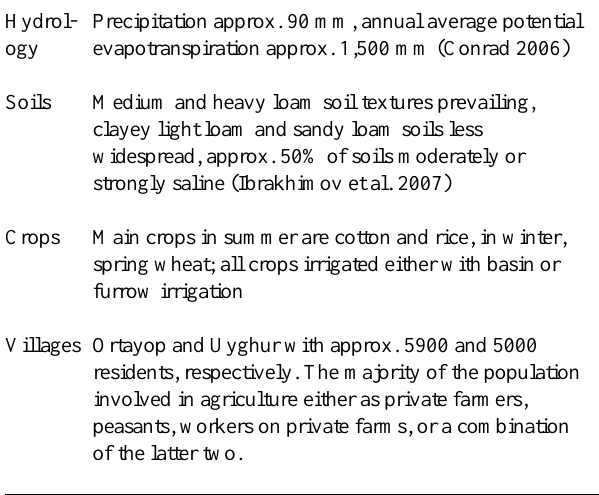
Table 1 . Characteristics of the study